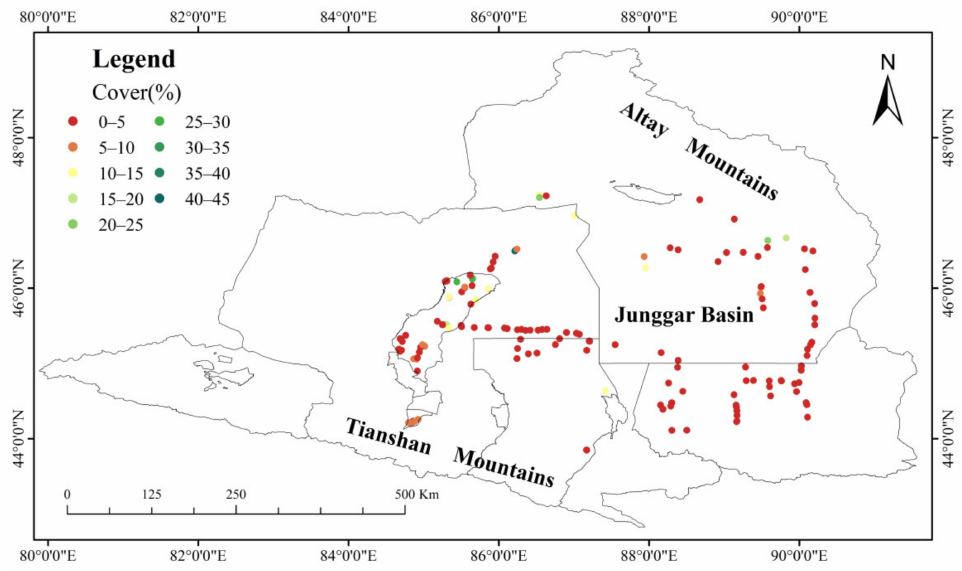
Figure 2. Spatial distribution of vegetation coverage in the sample plots taken by UAVs from 2019–2021 (n = 171). Table 3. Linear regression analysis of vegetation coverage based on the vegetation index (n =